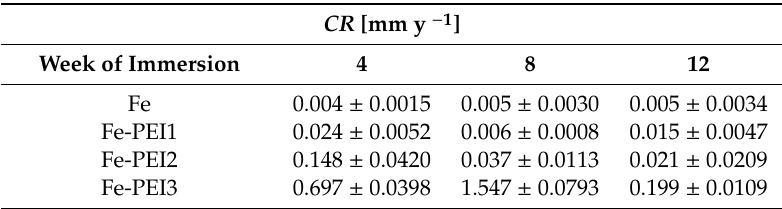
in Hanks’ solution at 37 ◦ C for 12